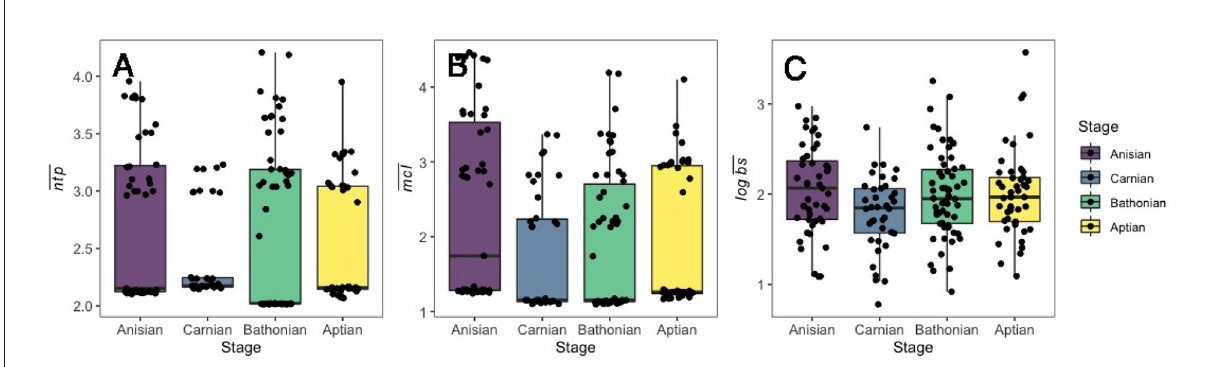
FIGURE1 Boxplots displayed for (A) ntp , (B) mcl , and (C) log bs for guilds in Mesozoic communities. Data only shown for guilds with associated body size data, and for those with ntp > 2.0. The number of guilds displayed in this figure for each stage are as follows: Anisian: 47; Carnian: 38; Bathonian: 58; Aptian: